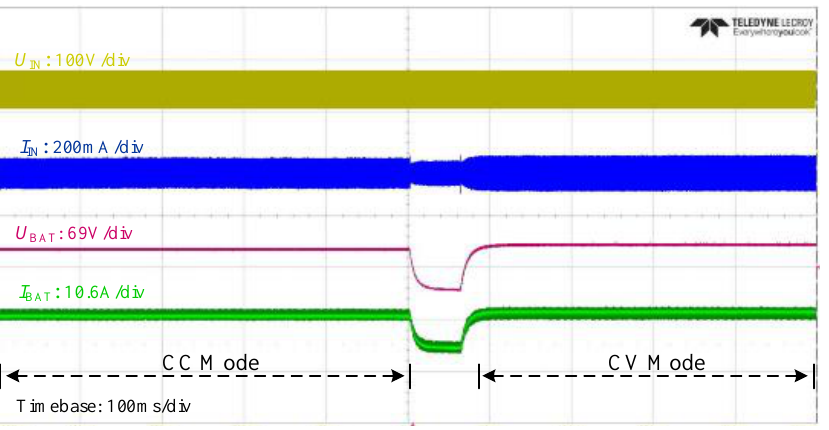
Figure 20. Transient waveforms switching process from the CC to CV charging mode for U IN , I IN , U BAT , and I BAT .